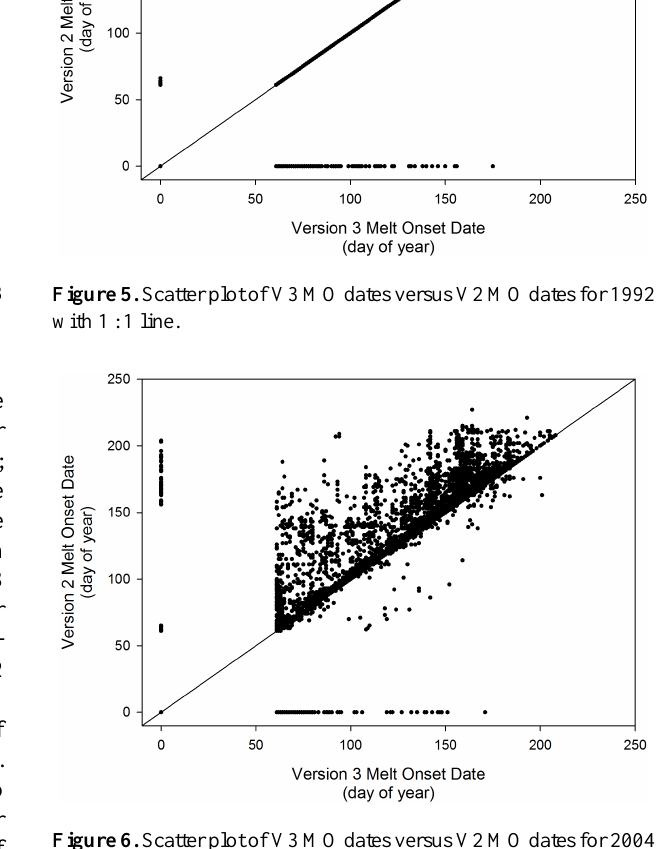
Figure 6. Scatter plot of V3 MO dates versus V2 MO dates for 2004 with 1:1